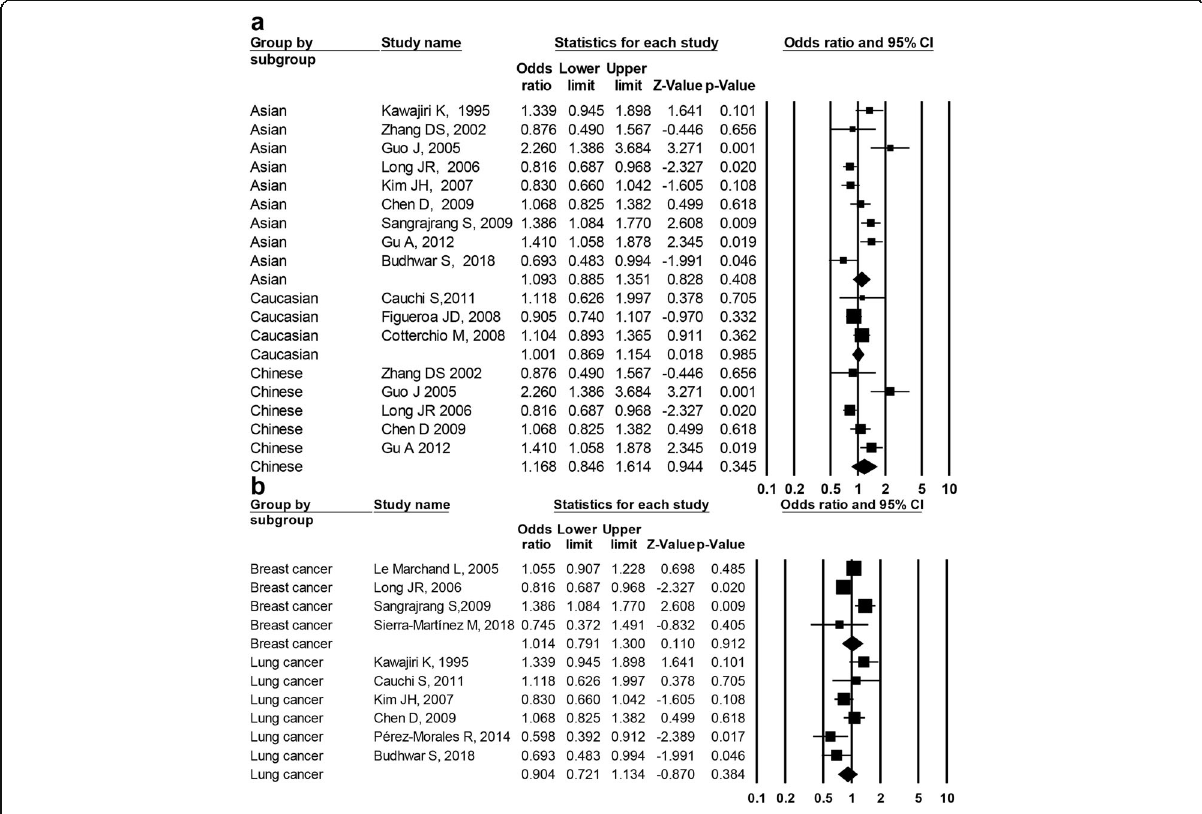
Fig. 3 Forest plot for AhR rs2066853 polymorphism and the stratified cancer risk in the dominant